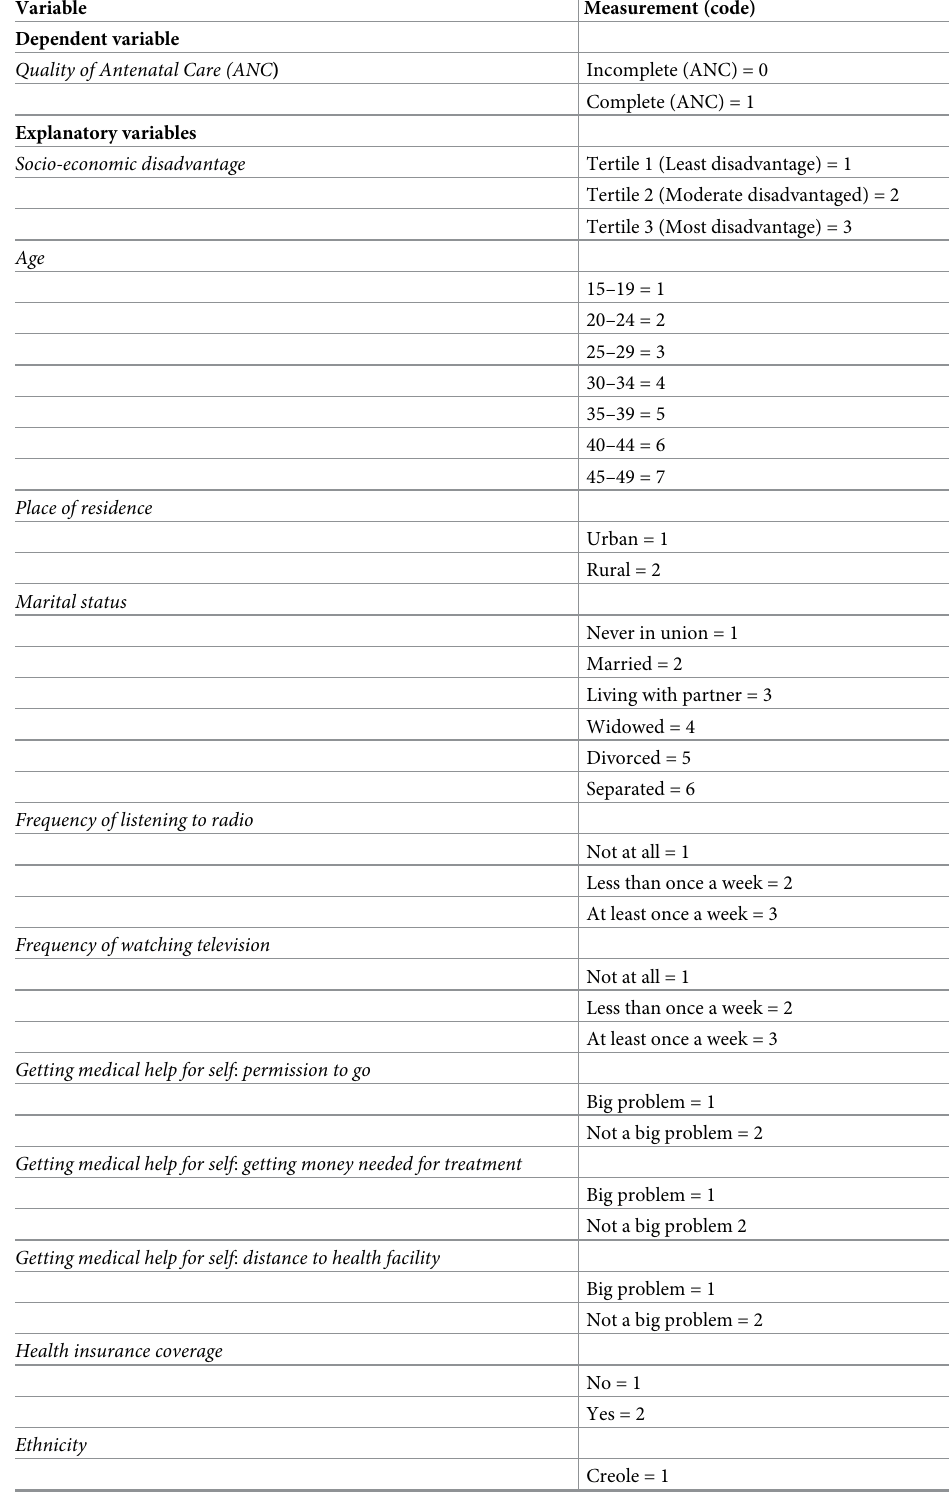
Table 1. Measurement of